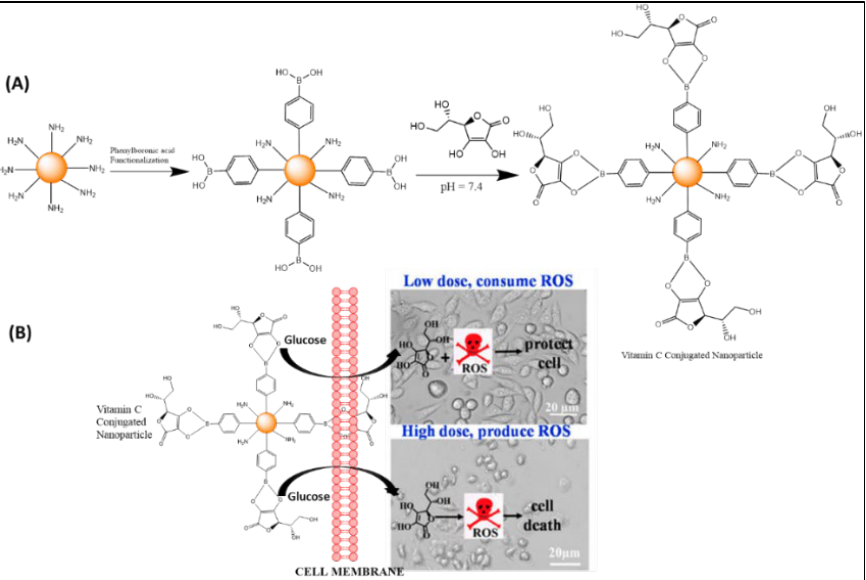
Figure 12. ( A ) Vitamin C-coated nanoparticles (Si@AuNP or PAPM) and ( B ) cellular oxidative Stress at concentrations of micro- and millimolar vitamin C.